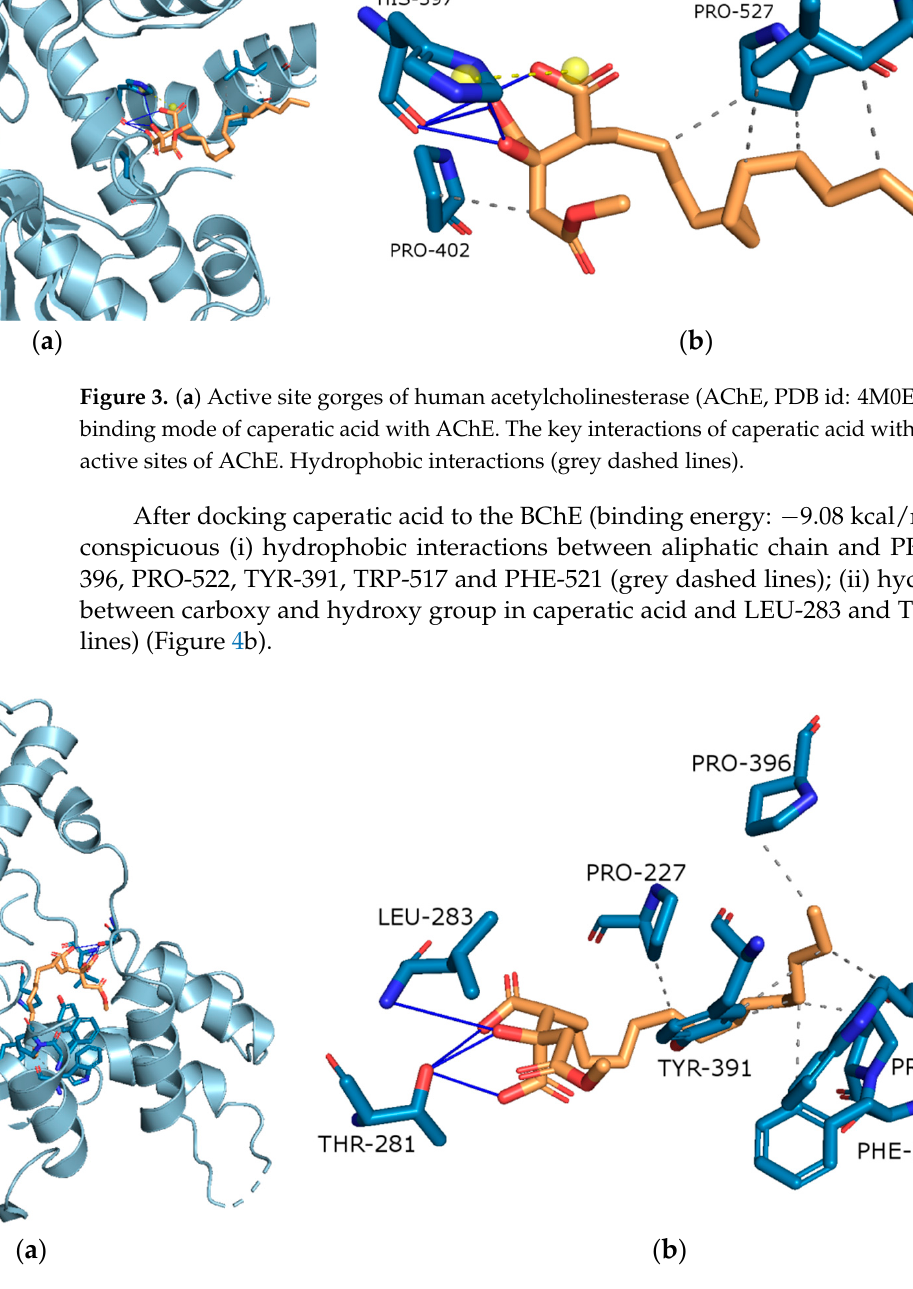
Figure 4. ( a ) Active site gorges of human butyrylcholinesterase (BChE, PDB id: 4BDS); ( b ) Proposed binding mode of caperatic acid with BChE. The key interactions of caperatic acid with residues in the active sites of BChE. Hydrophobic interactions and hydrogen